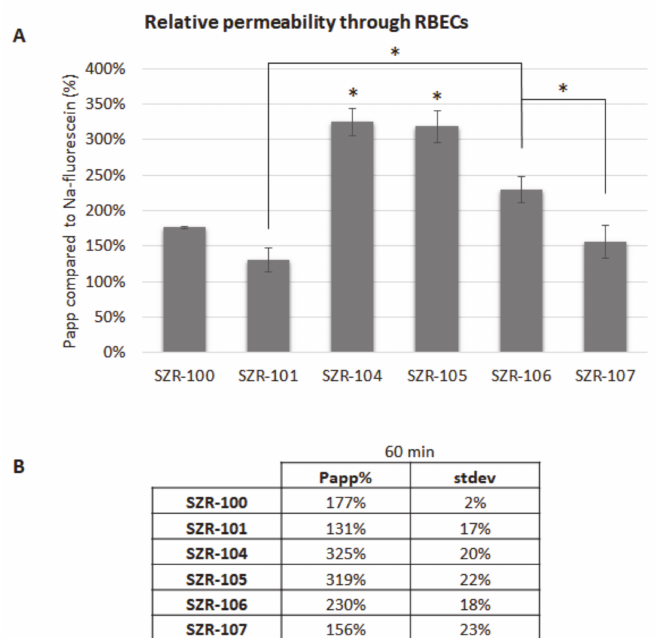
Figure 5. Penetration of KYNA analogues through the BBB. ( A ) Permeability of KYNA derivates after 60 min compared to sodium-fluorescein. N = 2, average ± SD (ANOVA and Bonferroni’s post hoc test). * p < 0.05 (SZR-104 and SZR-105: significant difference compared to all other groups; significant difference between SZR-106 and SZR-101 or SZR-107). ( B ) Permeability coefficients of KYNA analogues after 60 min compared to sodium-fluorescein.